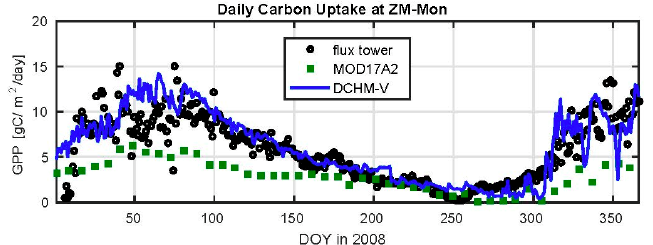
Figure 7. Time series of daily GPP in 2008 from MODIS MOD17A2 (square), CarboAfrica flux tower data (circle), and the DCHM-V estimates at the same location. Note the significant difference between MOD17A2 and the DCHM-V estimates. The location of the ZM-Mon tower within the UZRB is shown in Figure